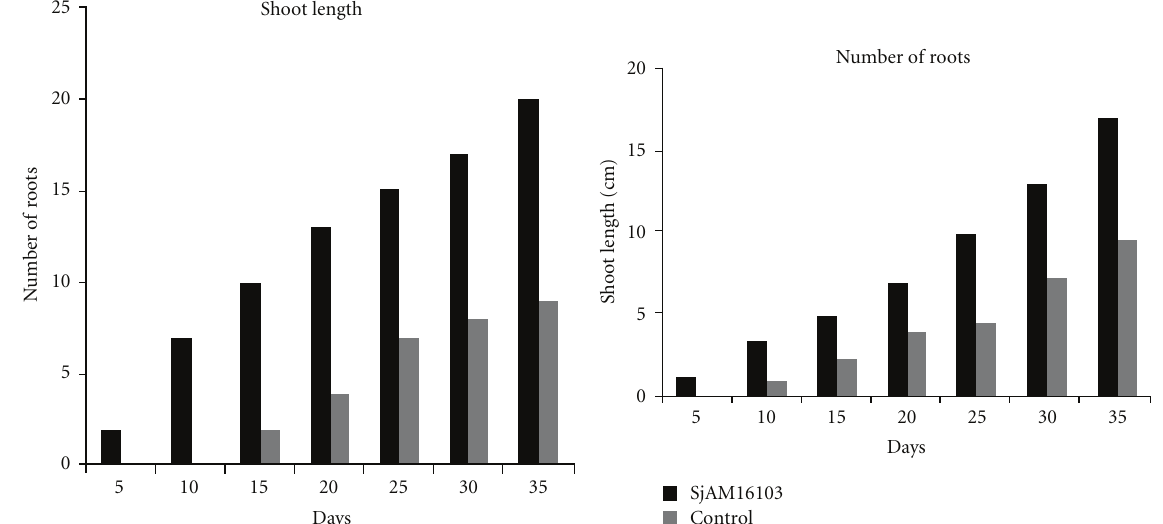
Figure 5: Inoculation of endophytic S. aquimarina SjAM16103 in E . triplinerve.